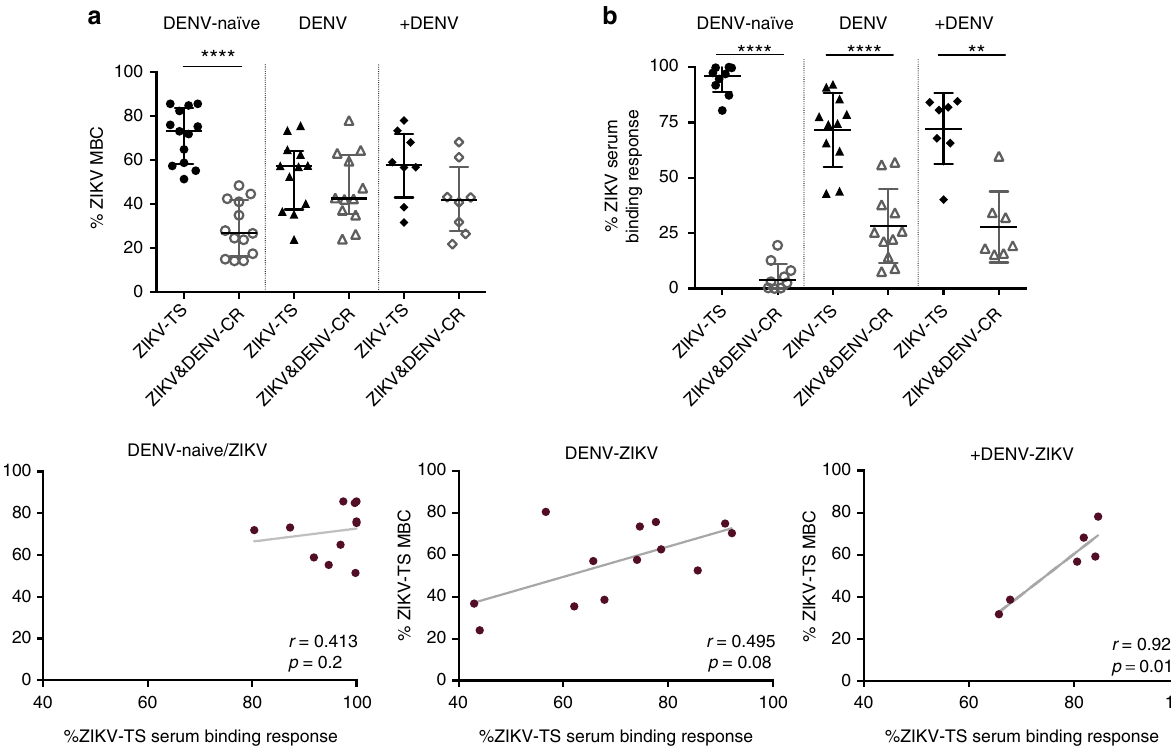
Fig. 5 ZIKV infection elicits a strong type-speci fi c binding response in serum antibodies. Analysis of the total ZIKV response in MBCs and serum from ZIKV-infected patients with no (DENV-naïve/ZIKV), one (DENV-ZIKV), or more than one ( + DENV-ZIKV) prior DENV infection. a Proportion of ZIKV type-speci fi c (TS) and cross-reactive (CR) responses over total ZIKV MBC response at ~8 months post-ZIKV infection. b Proportion of ZIKV type-speci fi c (TS) and cross-reactive (CR) responses over total ZIKV serum antibody-binding response at ~8 months post-ZIKV infection. DENV-reactive antibodies were depleted from patient sera to obtain the proportion of the ZIKV response that is due to only ZIKV type-speci fi c antibodies. c Correlation of the proportion of ZIKV TS responses in MBCs and serum. The median and IQR are shown for a and b . Signi fi cance was determined by Mann – Whitney test for a and b , and correlation analysis in c was performed using Spearman r test. * p < 0.05, ** p < 0.01, *** p < 0.001. The sample size for each group is as follows: DENV-naïve/ZIKV MBC, n = 13 and serum n = 10; DENV-ZIKV, MBC n = 12 and serum n = 11; + DENV-ZIKV MBC n = 8 and serum n =